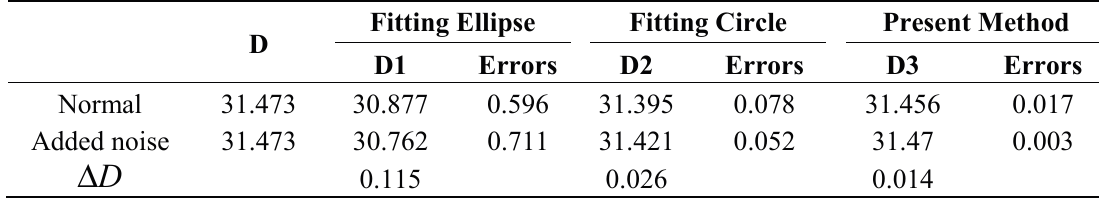
Table 10. Measurement results for shaft 2